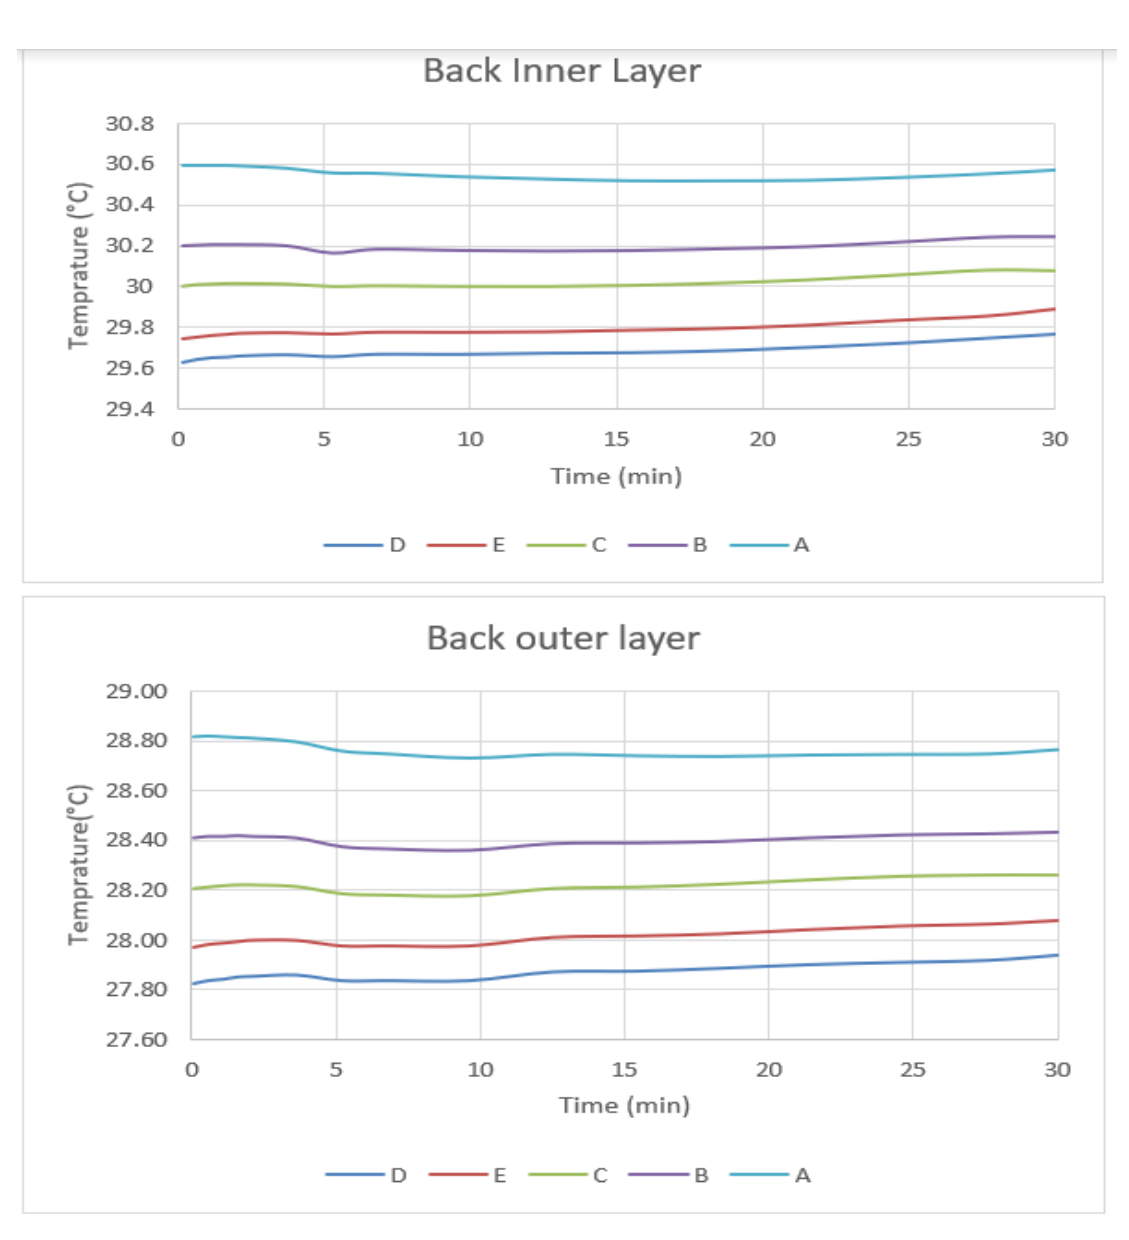
Figure 6. Inner layer and Outer layer temperature of five garment sizes.